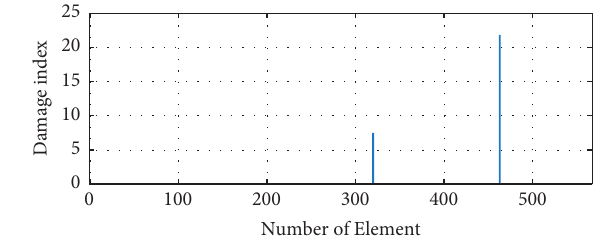
Figure 33: Results of multidamage case D4 using MCA-DI (building with the unsymmetrical distribution of